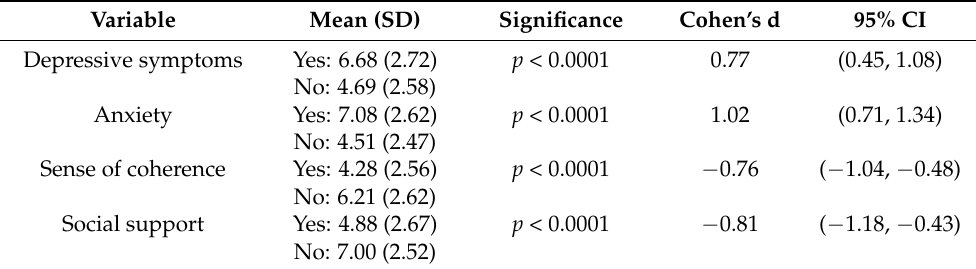
Table 2. Differences in means of subjective burden in the subgroups of women with and without depressive symptoms, anxiety, sense of coherence and social support. Variable